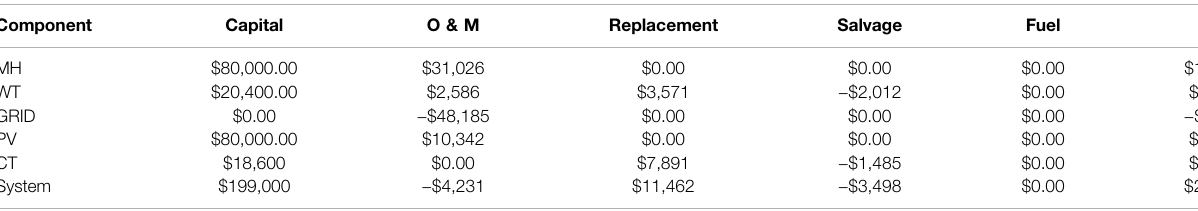
TABLE 4 | Detail cost analysis of HRES.